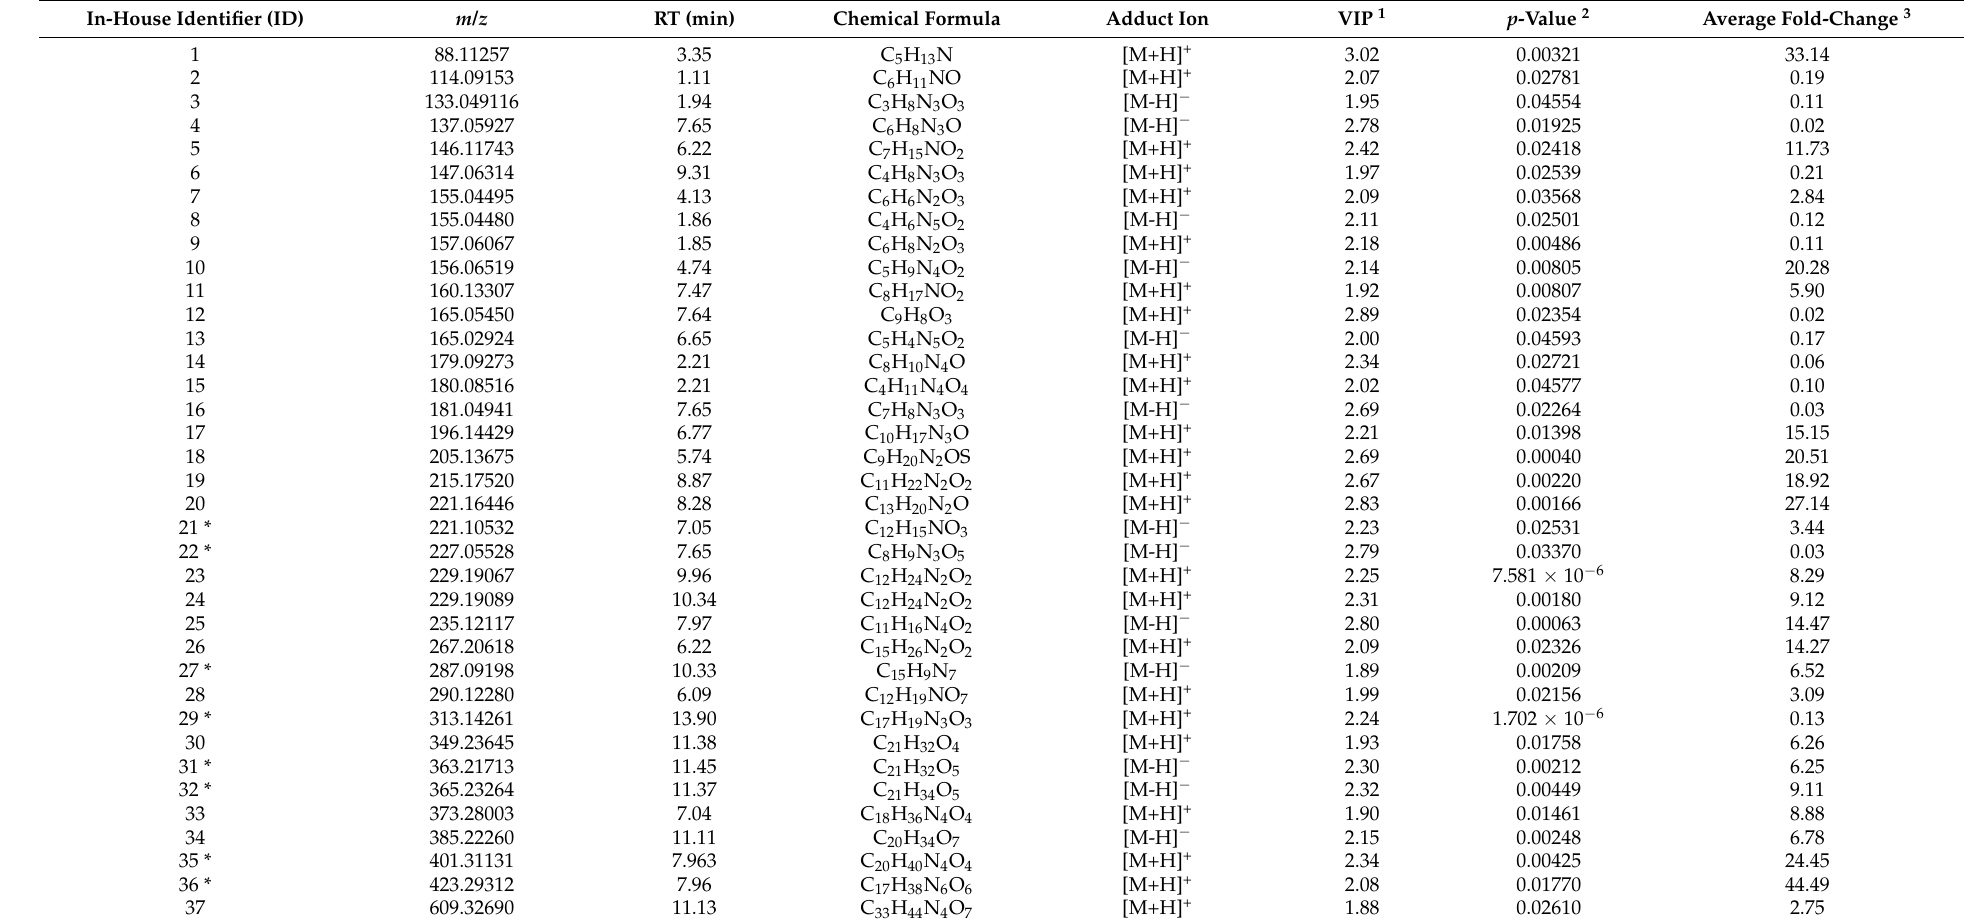
Table 1. The 37 Gram-negative bacterial endotoxin potential markers, retained after multivariate statistical analysis, with the assignment of a chemical formula using SIRIUS software. In-House Identifier